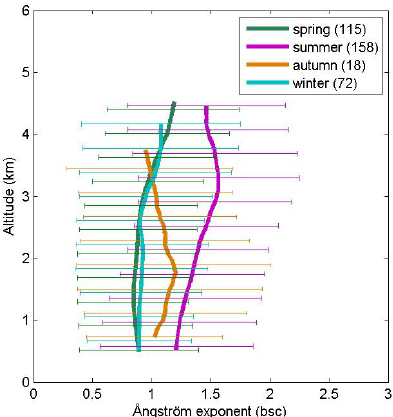
Fig. 6. Seasonal averaged ˚Angstr¨om exponent for backscatter (AE bsc 355 − 1064 ) with standard deviations. The value in the legend indicates the number of profiles used in